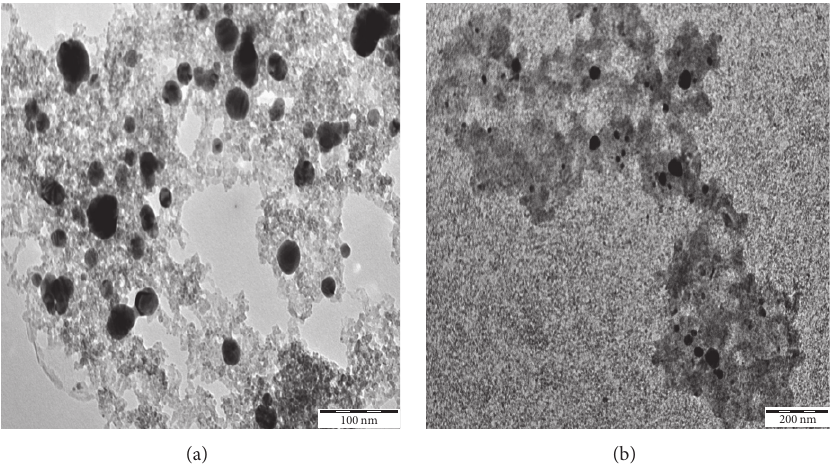
Figure 4: TEM images of silver nanoparticles at energy of (a) 700 mJ for 6ns pulse duration and (b) 720 mJ for 6ns pulse duration.